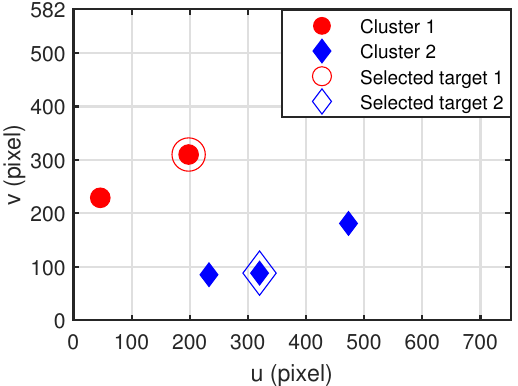
Figure 6. The initial target distribution and selection results.